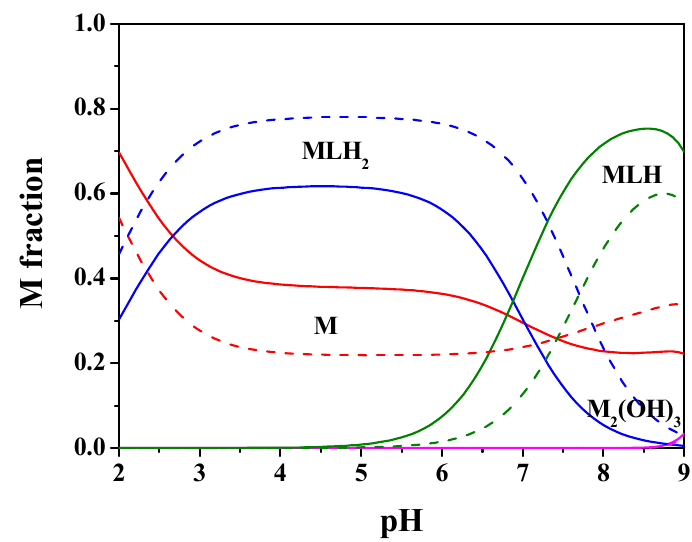
Figure 5. Speciation diagram of Mn 2+ - Amox (L) system, at C M = 2 mmol L − 1 , C L = 4 mmol L − 1 , t = 25 °C, I = 0.15 mol L − 1 (solid line), I = 1 mol L − 1 (dashed line).